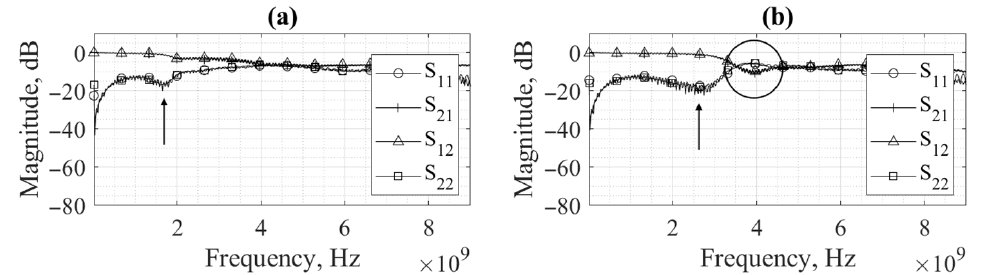
Figure 6. S parameters of the 4th section of the PMN-PZT-PG system with the lowest ( a ) and highest ( b ) PT concentrations.